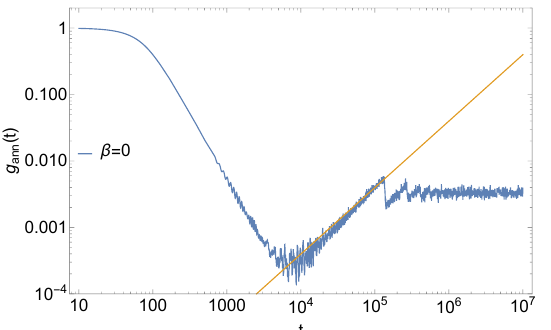
Figure 15. Annealed SFF for 3 d Rindler normal modes with fixed n = 1 , β = 0 , a = 1 , R = 2 and J = 300 . Averaging is done over hundred randomly chosen ξ cut with mean µ = 20 and variance σ = 0 . 1 . The equation of yellow straight line in the figure is log g ( t ) = log t ann